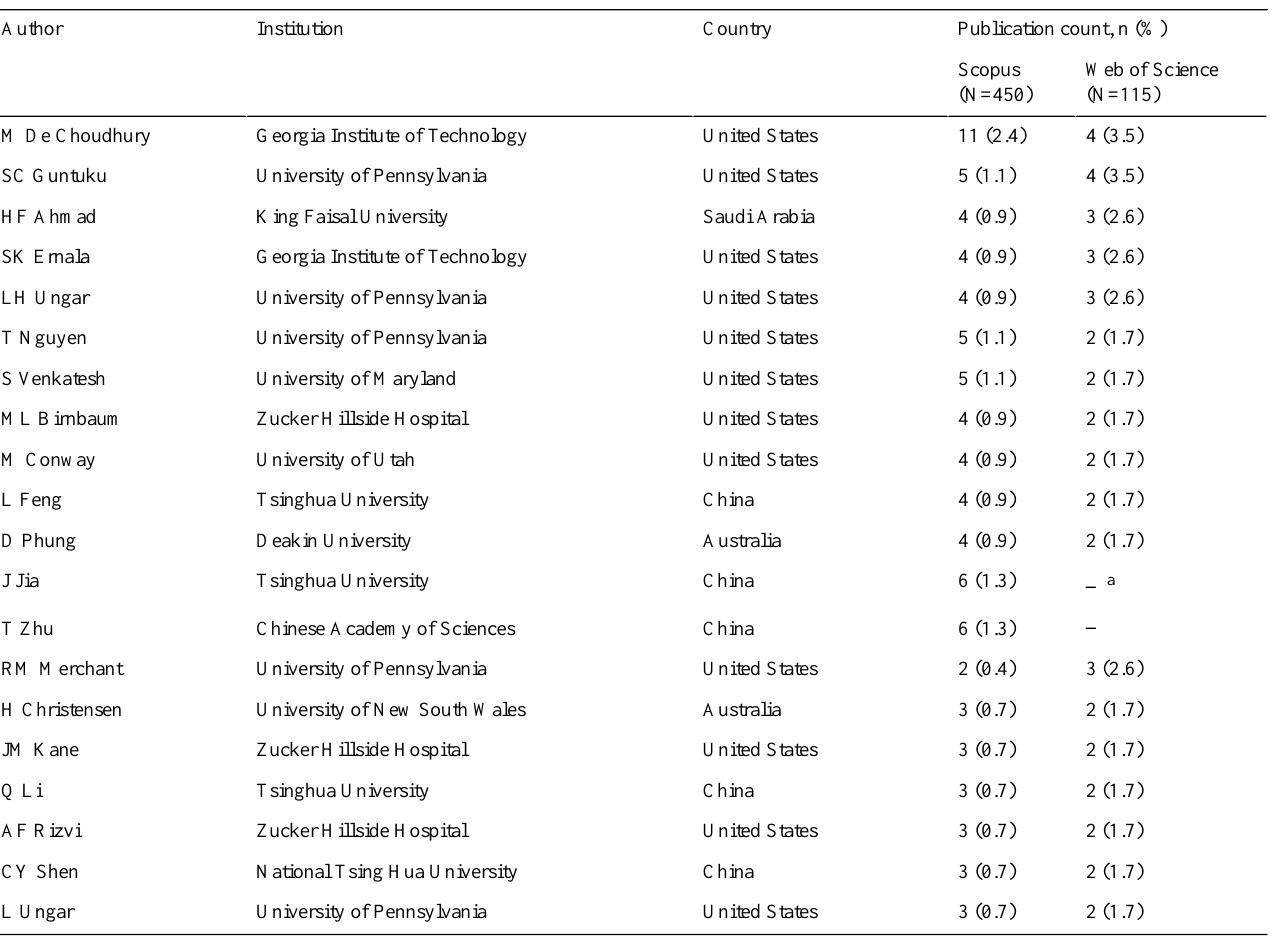
Table 6. Top 20 productive authors.